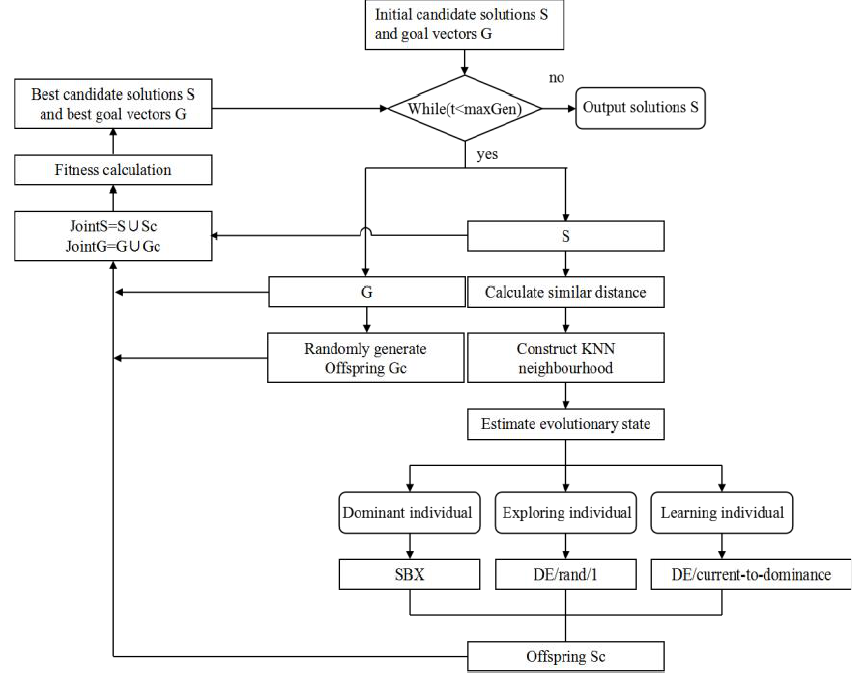
Figure 4. PICEA-g-AKNN framework.